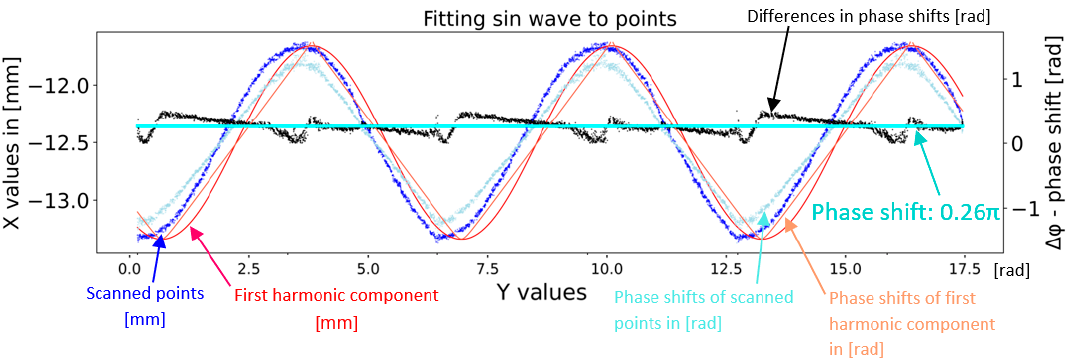
Figure 9. Fitting the computed first harmonic frequency and compensation sinusoidal wave.